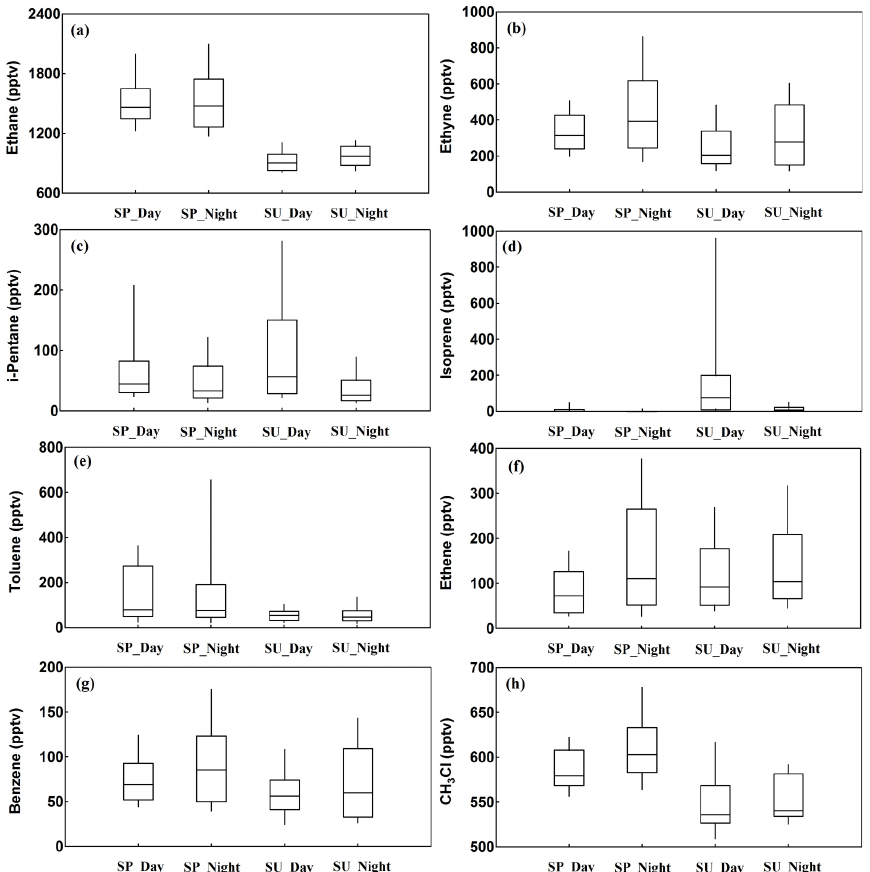
Fig. 2. Diurnal patterns of (a) ethane, (b) ethyne, (c) i -pentane, (d) isoprene, (e) toluene, (f) ethene, (g) benzene, and (h) CH 3 Cl at WLG in spring (SP) and summer (SU). The box plot gives the 90th, 75th, 50th, 25th, and 10th percentiles of the measurement